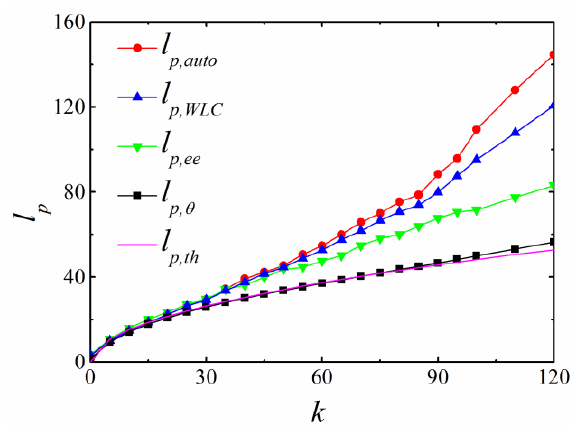
Figure 7. The persistence lengths as a function of bending constant k when CSA potential was applied in BFM.